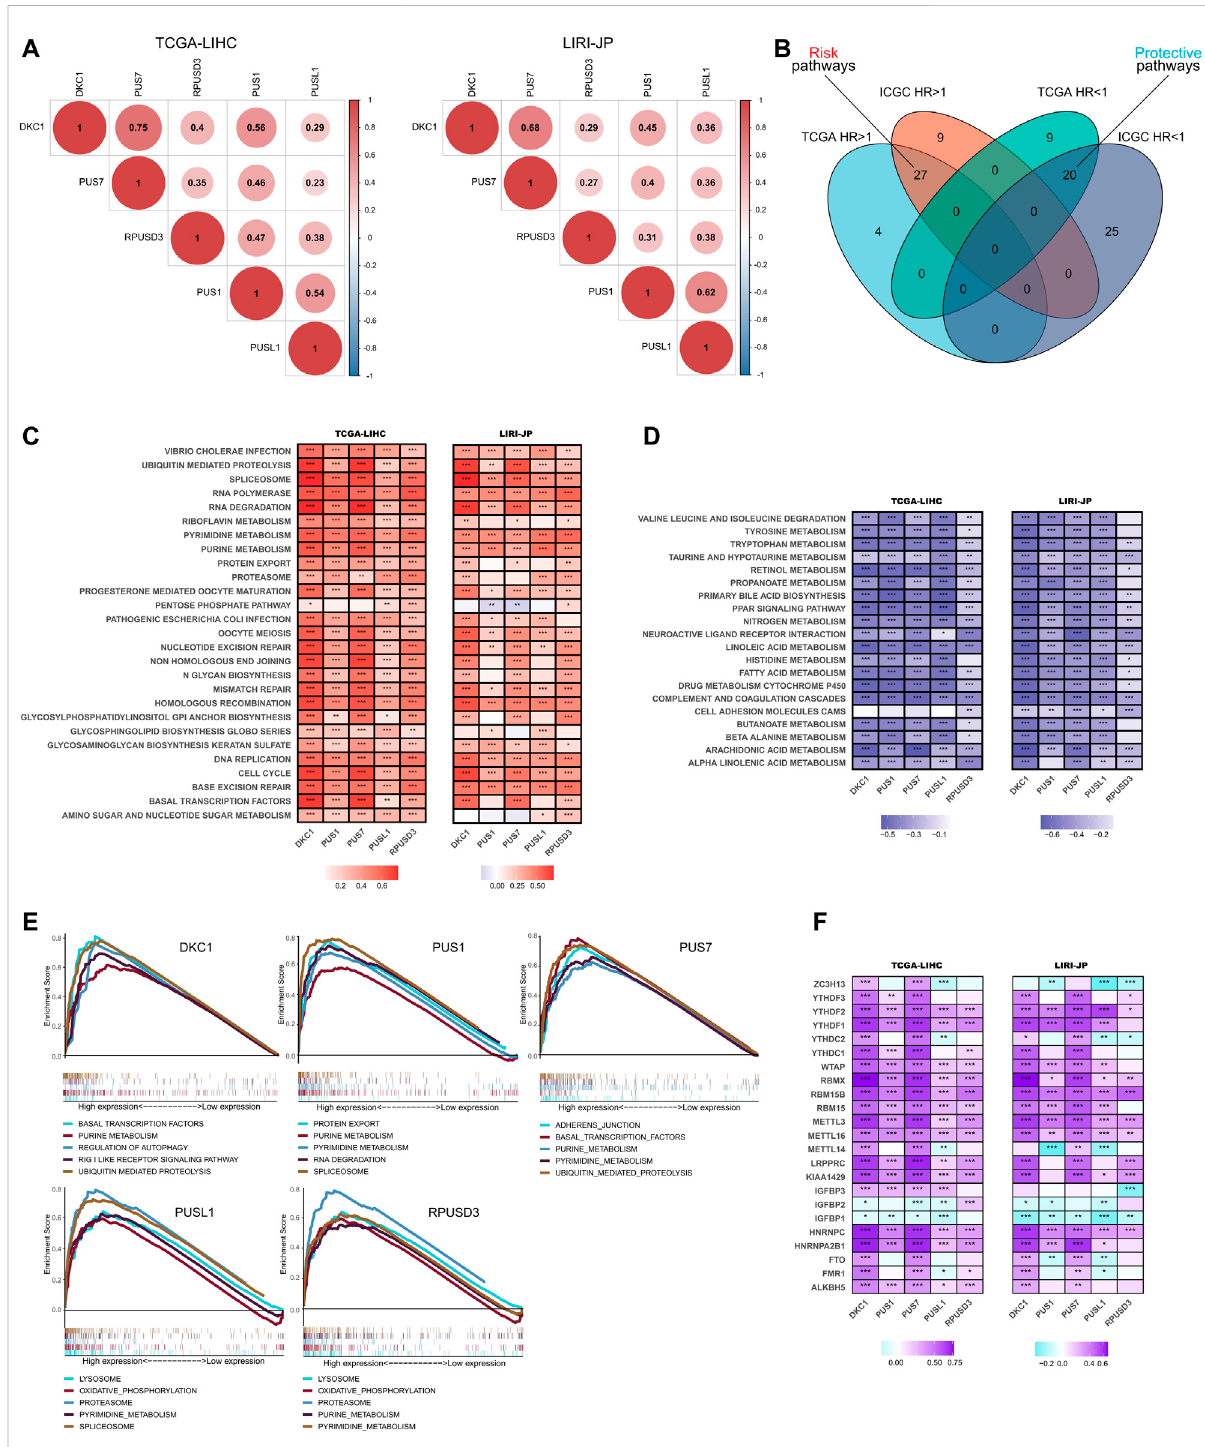
FIGURE 6 Functional analysis of PUSs in HCC. (A) Correlation of fi ve prognosis-related PUSs expression; (B) Venn diagram of prognosis-related pathways (GSVA scores) in TCGA-LIHC and LIRI-JP; (C – D) Correlation of PUSs expression with GSVA scores of risk pathways (C) and protective pathways (D) ; (E) Top fi ve KEGG pathways in high PUSs expression group based on GSEA; (F) Correlation of PUSs expression with m6A regulators expression. (* p < 0.05, ** p < 0.01, and *** p <